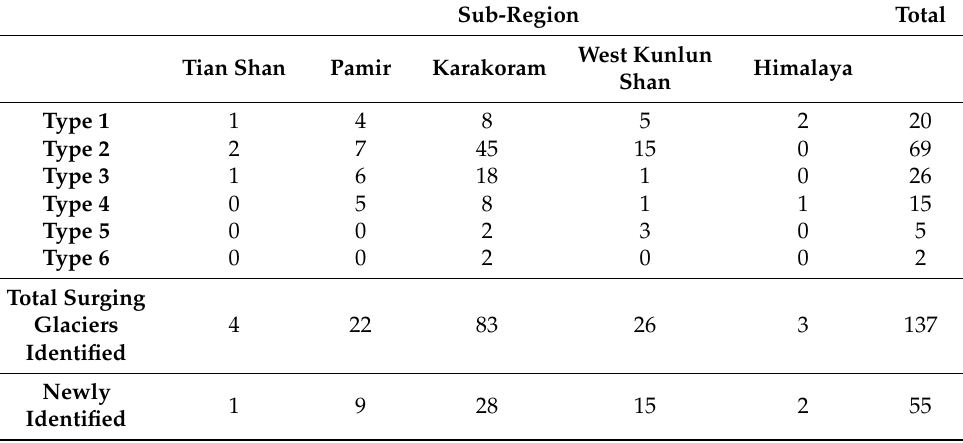
Table 1. Total numbers of glaciers identified as surging in this study and their respective phenomeno- logical classifications. Newly identified glacier totals also